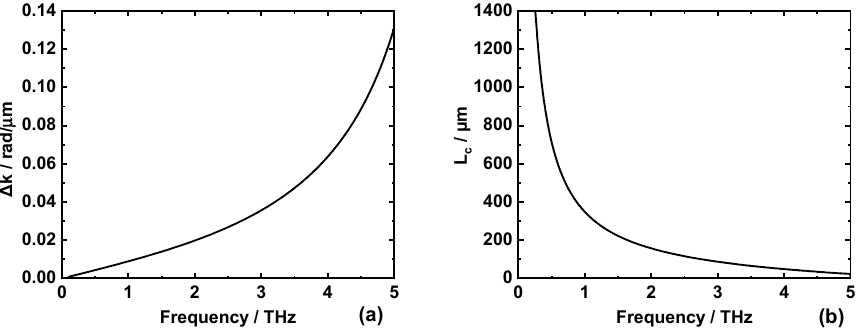
Figure 4. Wave vector mismatch ∆ k ( a ) and coherent length L c ( b ) of OR in ZnSe pumped at 1064 nm.